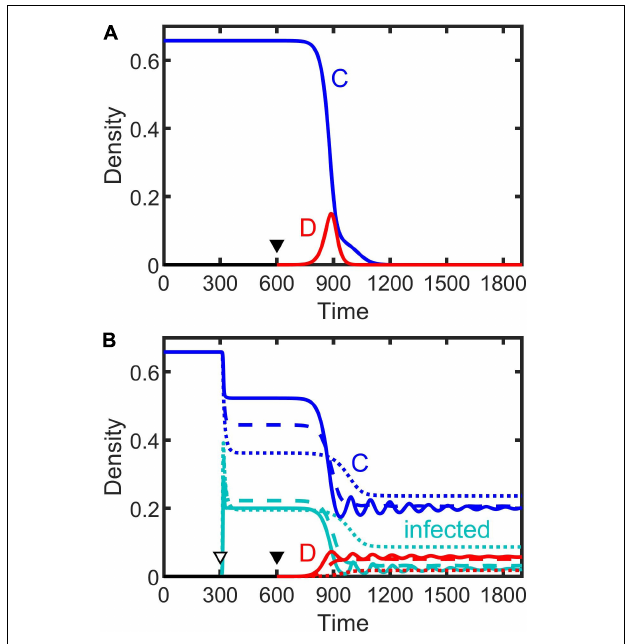
FIGURE 5 | Population extinction driven by invasion of defection (A) , as shown by dark gray in Figures 1A,C , which can be prevented by infection with a high transmission rate (B) . Solid triangles indicate when defectors invade a cooperative population, and the hollow triangle denotes when it is infected. Solid, dashed, and dotted lines result from the SI, SIS, and SIR model, respectively. Parameters: β = 0 . 9, κ = 0 . 9, γ = 0 . 1, δ = 0 . 2, and the others are the same as Figures 1A,C .